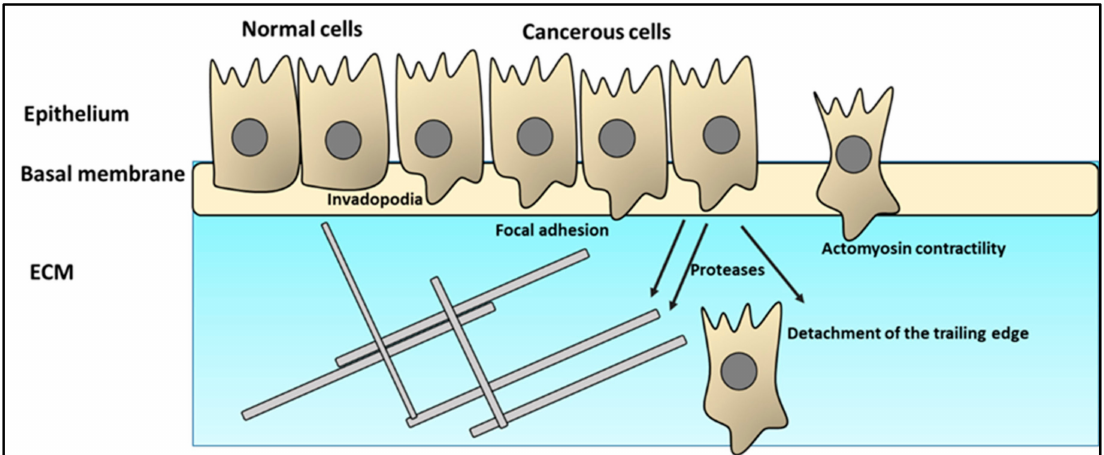
Figure 2. Cancer cell infiltration of the ECM. The process constitutes several phases such as (1) pseudo- pod protrusion formation, (2) construction of focal contacts, (3) focalized proteolysis, (4) actomyosin contraction, and, finally, (5) the detachment of the trailing